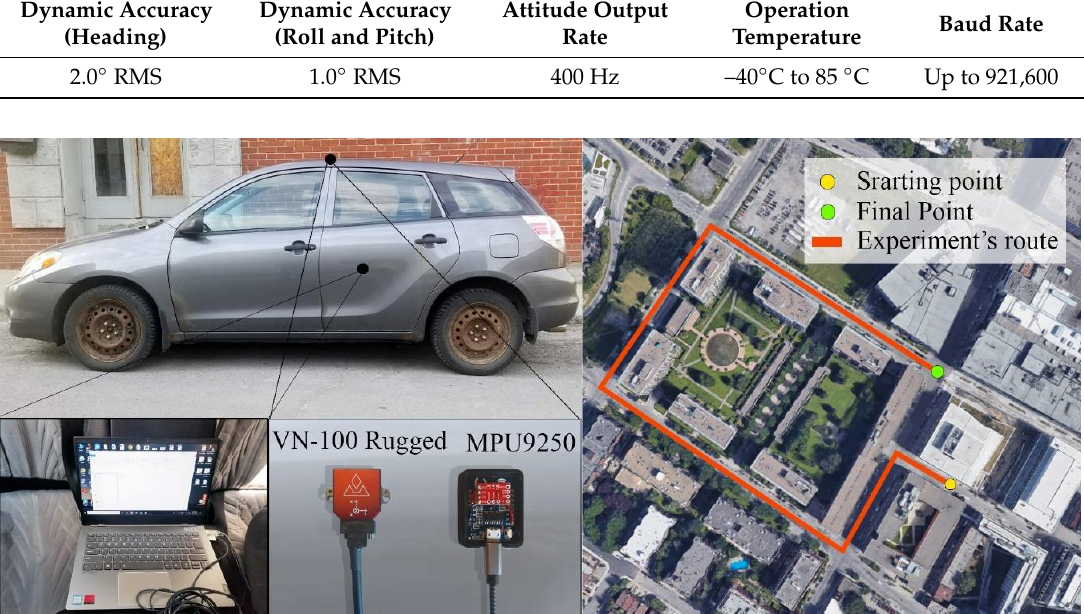
Figure 7. Dynamic experiment’s equipment and the experiment’s path. Table 4. Specification of the VN-100 Rugged AHRS board.